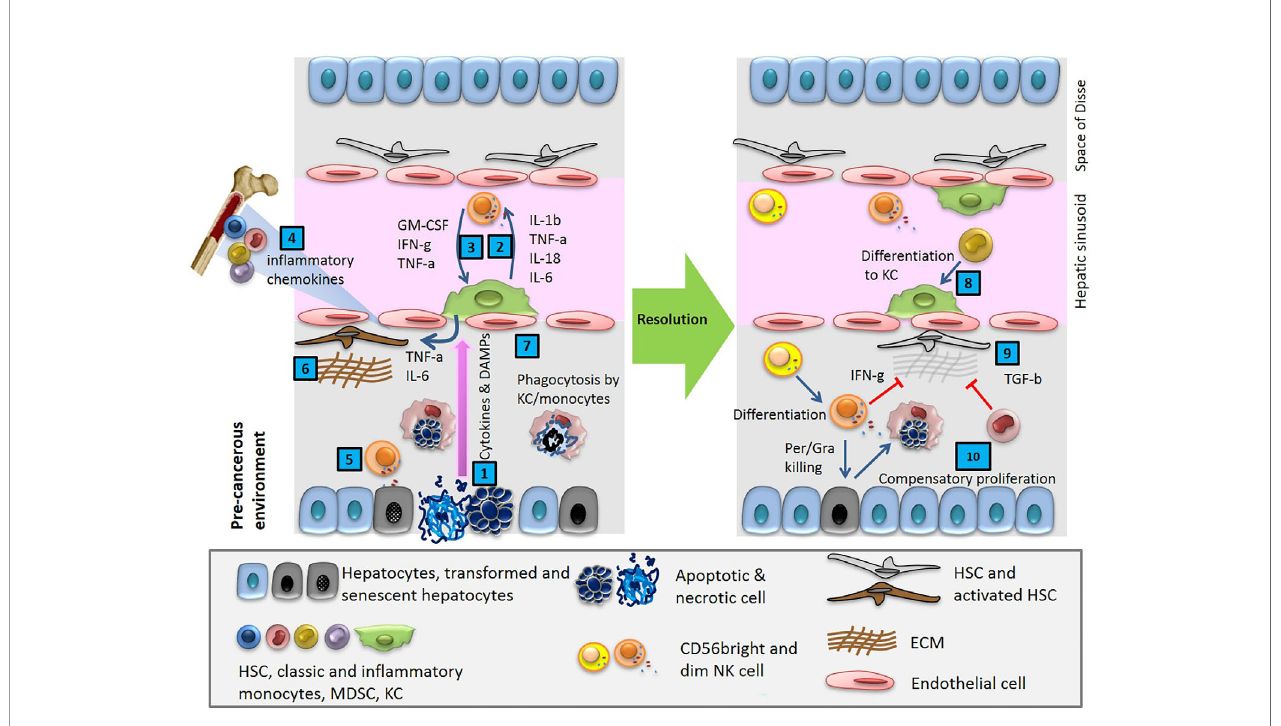
FIGURE 1 | Cytokines and DAMPs released in pre-cancerous environment activate innate immune cells, resident macrophages (KC) and NK cells, and induces HSCs traf fi cking from BM. After a cycle of cytotoxic NK cell mediated cell death and phagocytosis of debris by macrophages, the tissue reaches